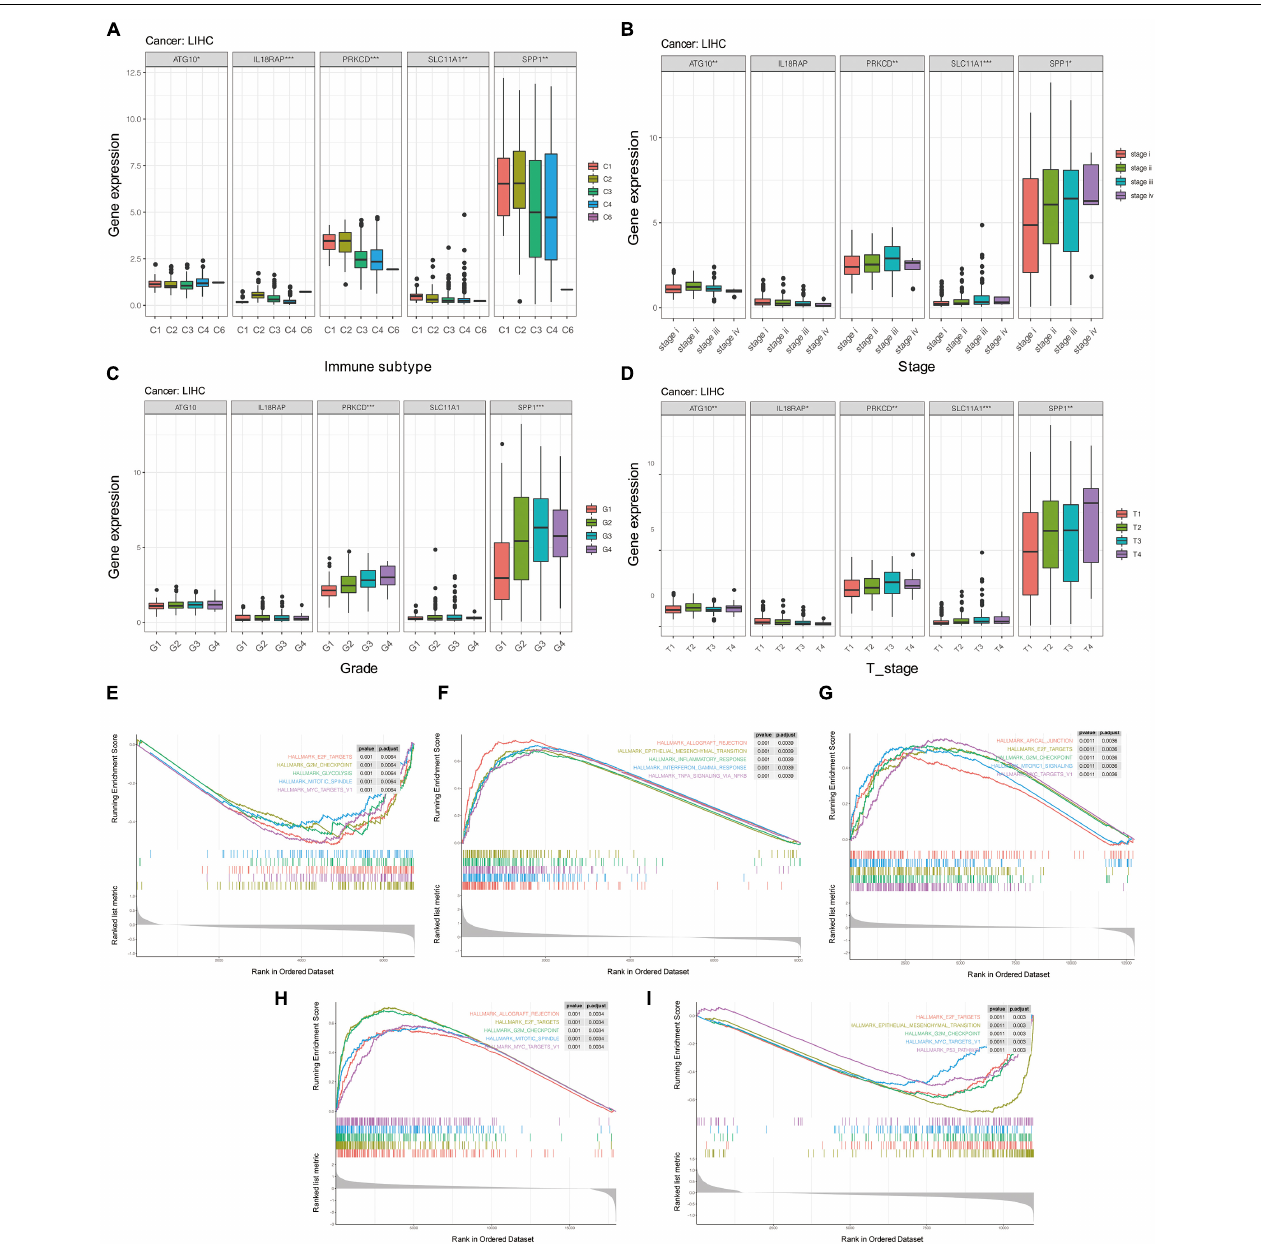
FIGURE 14 | The potential mechanism of five genes in HCC. (A) Correlation between five genes and immune subtypes of pan-cancer. (B) Correlation between five genes and clinical stage. (C) Correlation between five genes and clinical grade. (D) Correlation between five genes and T stage. (E–I) GSEA enrichment analysis of ATG10, IL18RAP, SPP1, PRKCD, and SLC11A1. * P < 0.05, ** P < 0.01, and *** P <